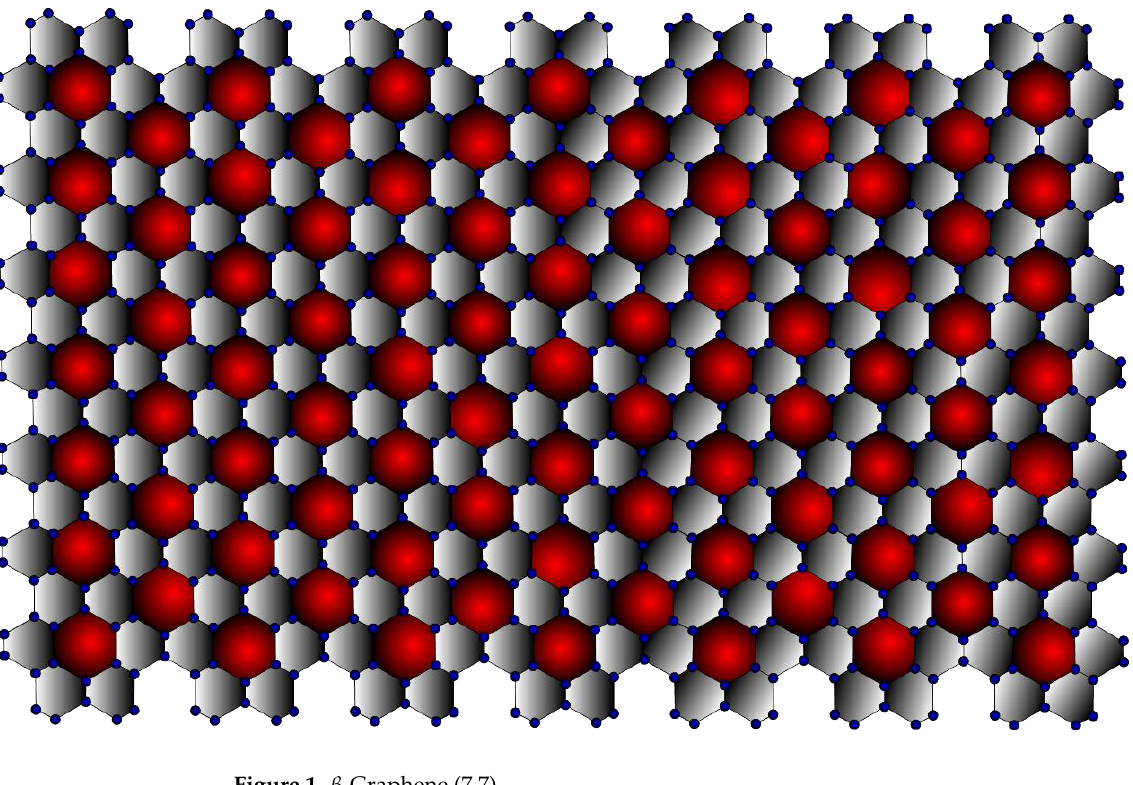
Figure 1. 𝛽 -Graphene